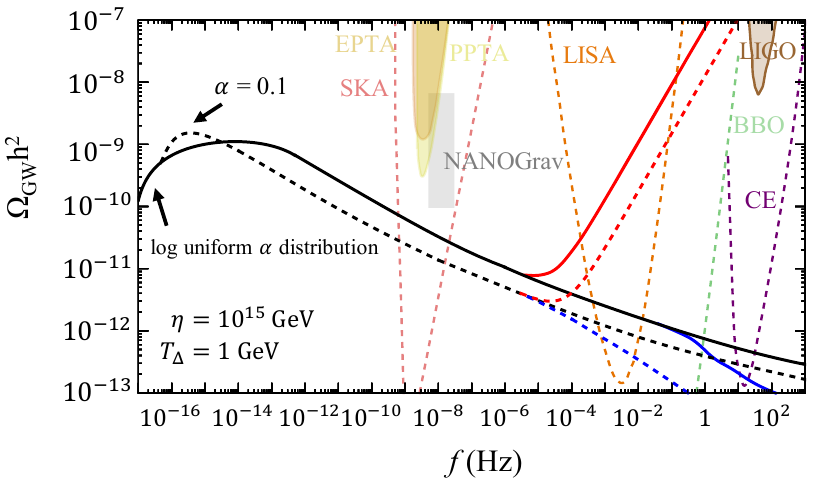
Figure 13 . Solid lines: GW spectrum with a logarithmic uniform loop size distribution (eq. (4.8)) for different cosmology backgrounds; dashed lines: results with a monotonous α = 0 . 1 as applied in previous sections (for comparison). For the cases with kination or EMD, the departure from standard cosmology is assumed to occur at T = 1 ∆